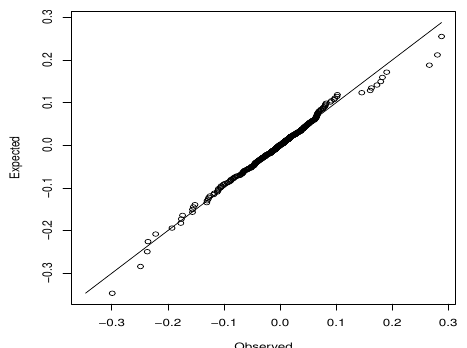
Figure 2. The Q-Q plots of the best fitting distributions for daily log returns of the exchange rates of Bitcoin (first row, left), Dash (first row, right), Dogecoin (second row, left), Litecoin (second row, right), MaidSafeCoin (third row, left), Monero (third row, right) and Ripple (last row) from 23 June 2014 until 28 February 2017.